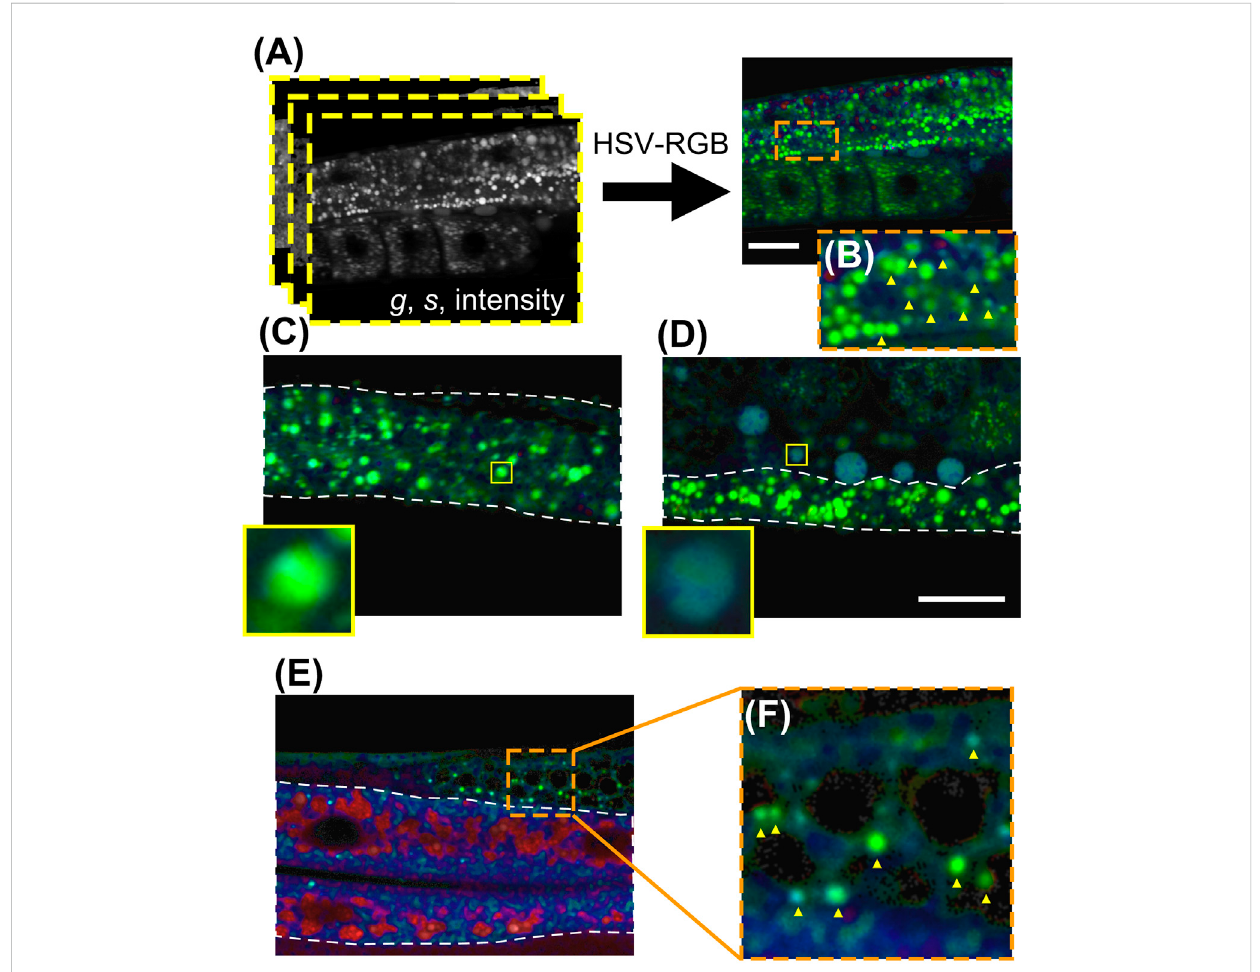
FIGURE 3 FLIM color representation. (A) Visualization of FLIM phasor data of a wild-type adult worm through HSV-RGB transformation. (B) The expansion image of the orange box is shown in (A) . (C) The FLIM color representation of an early L4 DHS-3::GFP transgenic worm stained with high-concentration Nile Red, where the inset is the expansion of a lipid-storage particle. (D) The FLIM color representation of an adult VIT-2::GFP transgenic worm stained with high-concentration Nile Red, where the inset is the expansion of a pseudocoelomic lipoprotein particle (PLP). (E) FLIM color representation of an adultwild-type worm stained with low-concentration Nile Red. (F) The expansion of theorange box in (E) . White dashed lines indicate intestine. Scale bar, 20 μ